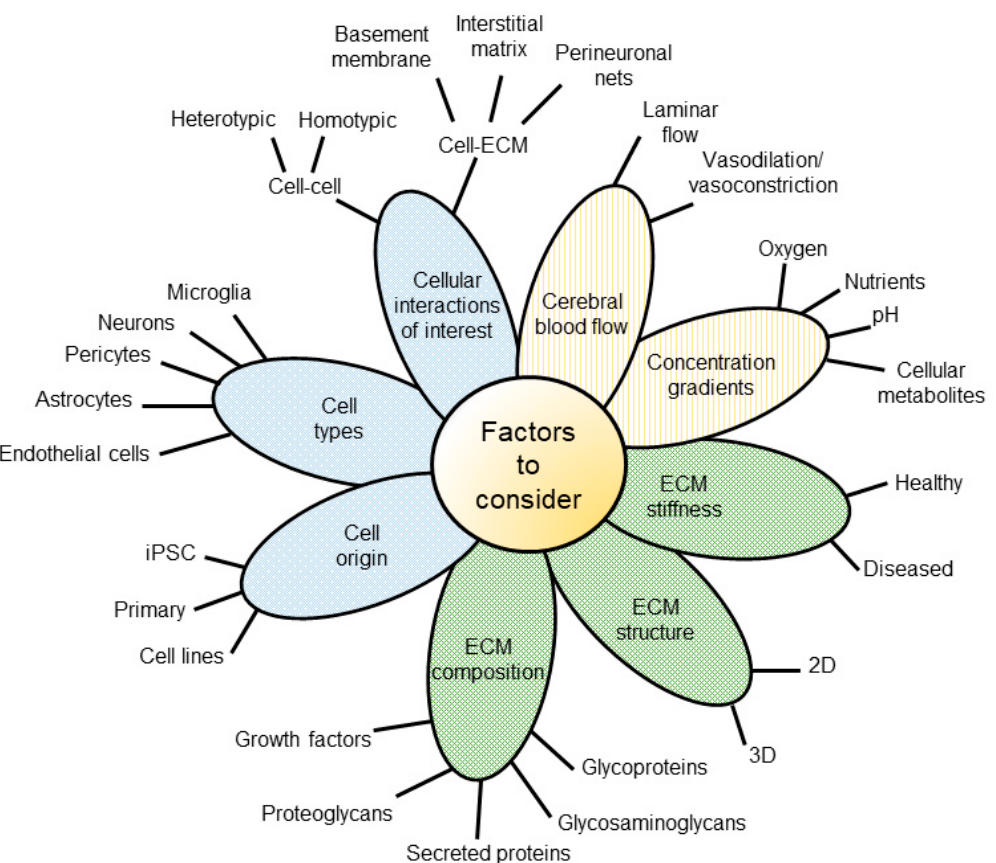
Figure 7 . Factors to consider when designing BoC models. Figure 7. Factors to consider when designing BoC